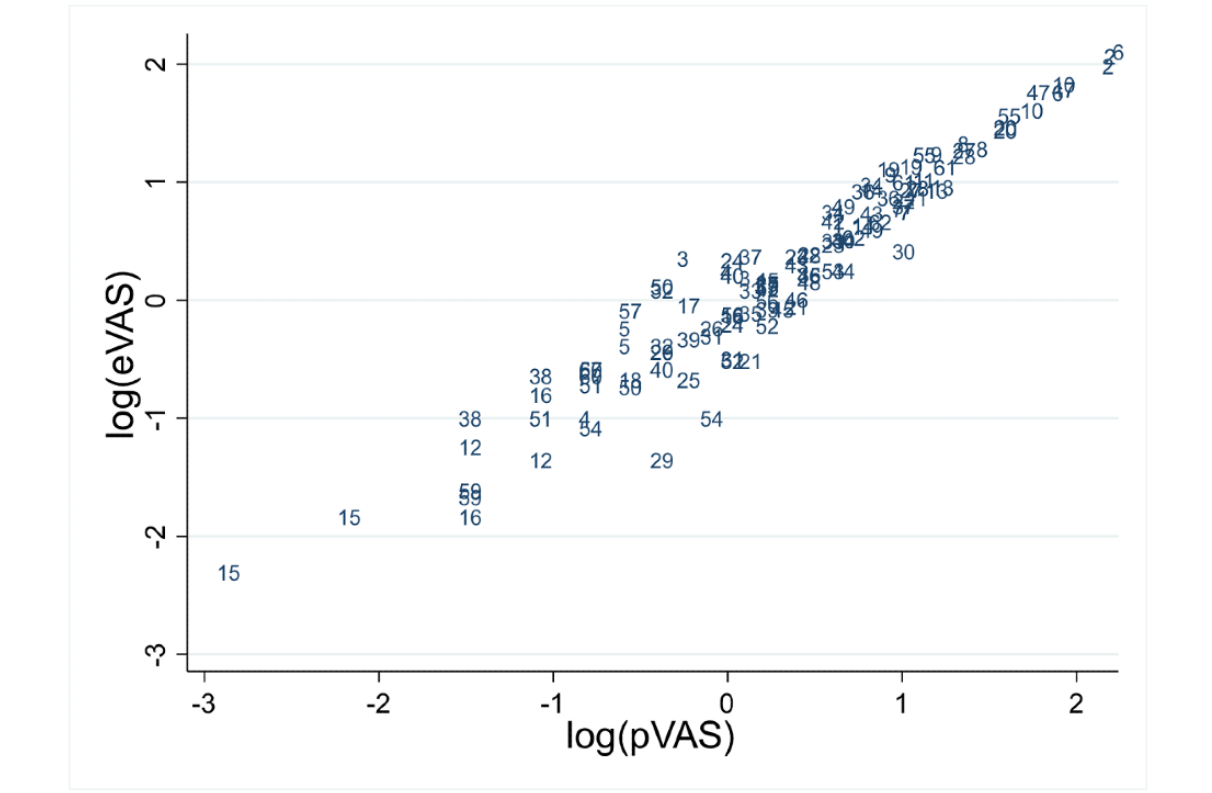
Figure 6. Scatter plot of the data (log) in adults. Points are represented by subject number. eVAS: electronic visual analog scale; pVAS: paper visual analog